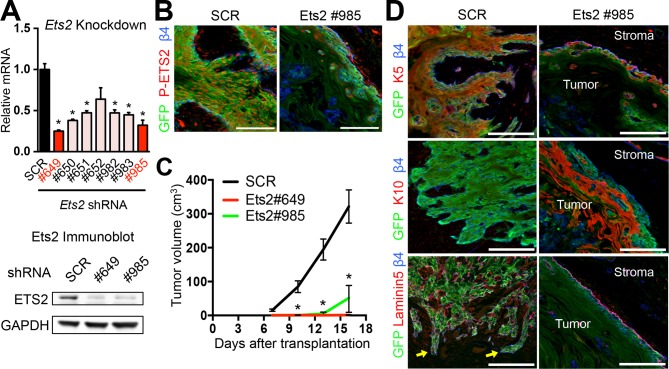
ETS2 governs SCC growth and malignancy.(A) (left) Knockdown efficiency of Ets2 shRNAs in HRasG12V; Tgfbr2-null cells as measured by quantitative RT-PCR. (n = 3 ± SEM *p<0.05). (right) Immunoblot analyses confirming that changes in mRNA levels are reflected at the level of protein. (B) Immunofluorescence image of allograft tumor (GFP) showing reduced ETS2 protein in Ets2 knock-down tumors. Scale bars, 100 μm. (C) Changes in tumor volume of Ets2 knock-down and control allografts over time (n = 3). (D) Immunofluorescence images of allograft tumors (GFP) of transduced SCC-SCs. Note reduction in undifferentiated K5+ cells and appearance of keratinized pearls of K10+ differentiated cells upon Ets2 knock-down. Of note, yellow arrows depict regions of discontinuous laminin5 and integrin β4 staining, indicative of a disrupted basement membrane and local tumor invasion. Scale bars, 100 μm. SC, stem cell; SCC, squamous cell carcinoma; SEM, standard error of the mean.